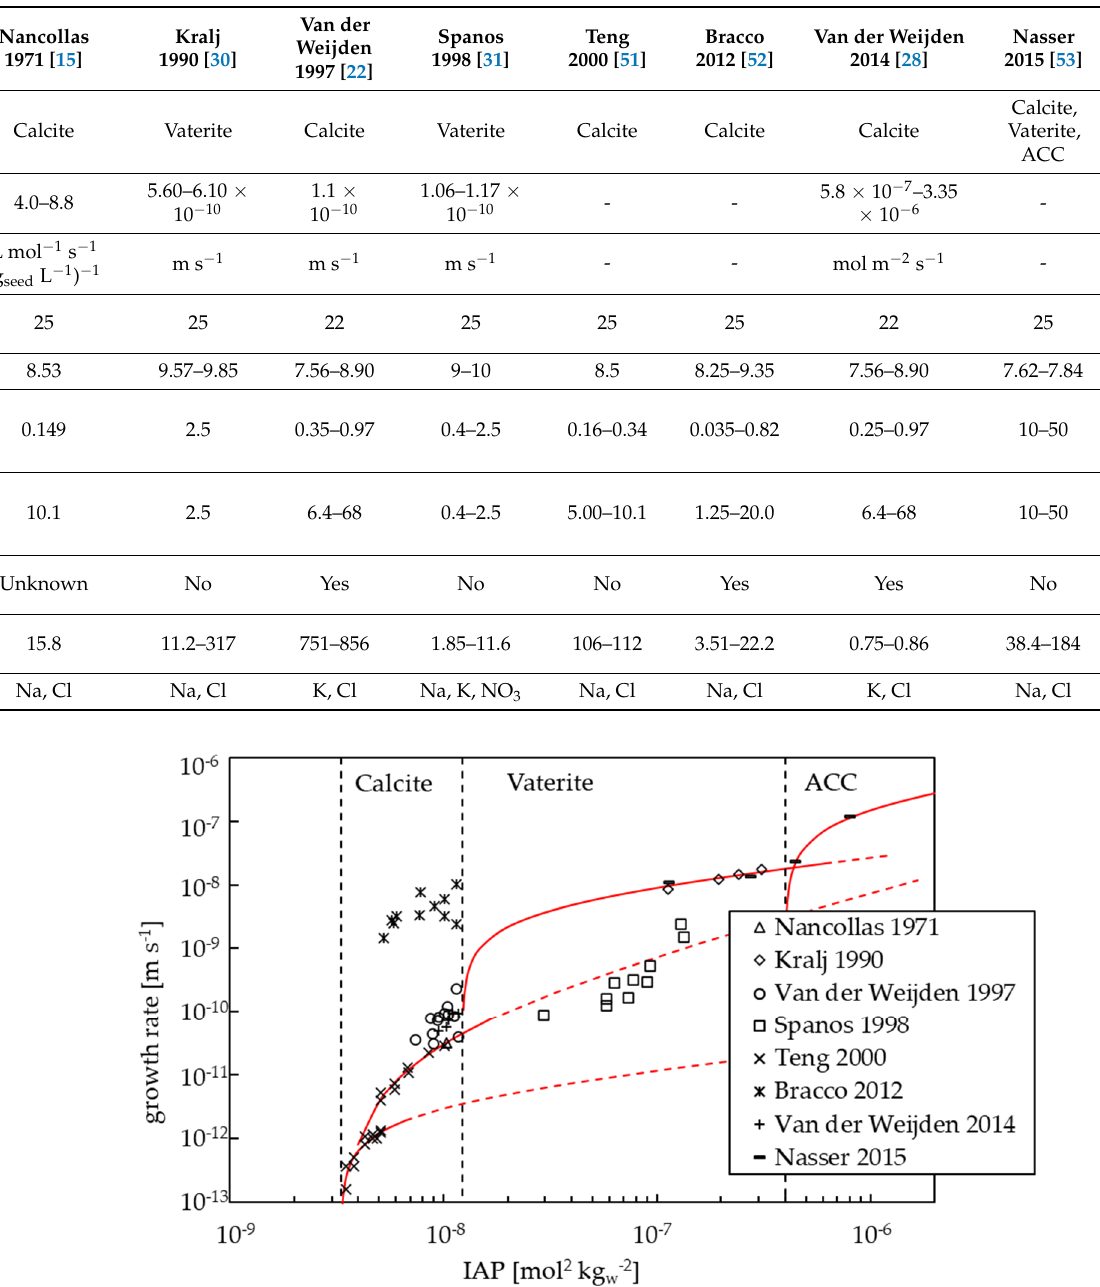
Figure 1. Selected growth data for the three polymorphs of calcium carbonate (from left to right calcite, vaterite and amorphous calcium carbonate (ACC)) plotted against the ionic activity product of calcium carbonate. The data of Nancollas, Kralj, Teng and Nasser were used to fit kinetic parameters, as shown in Figures 2–4. From left to right, the growth types are calcite spiral growth, calcite mixed growth, vaterite growth and ACC growth. As the ionic activity product increases, less stable polymorphs become the dominant growth type. The red lines are the trend lines, which were fitted by using the selected data for each growth mechanism or mineral type, as shown in Figures 2–4.